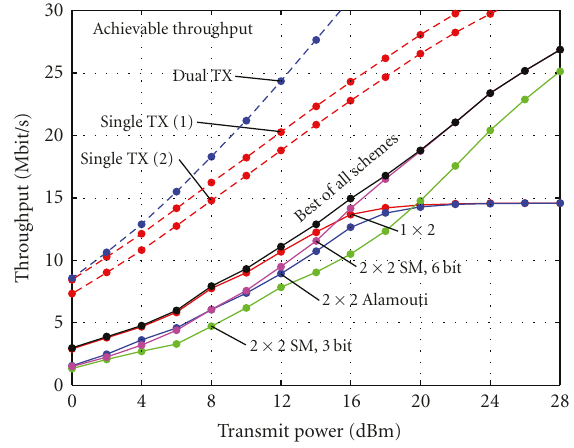
Figure 11: Scenario 3, measured (solid) and achievable (dashed) data throughput in the LOS outdoor-to-indoor scenario using two receive antennas. The largest transmit power corresponds to a receive SNR of about